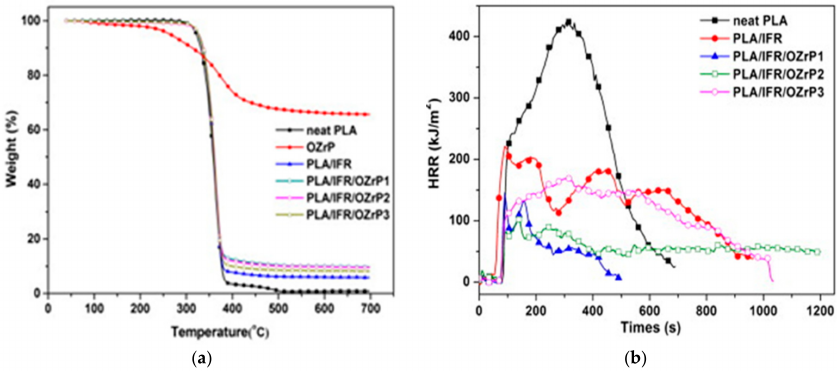
Figure 5. ( a ) TGA of PLA/IFR/ α -ZrP composites; and ( b ) heat release rate of PLA/IFR/ α -ZrP (Adapted with permission from